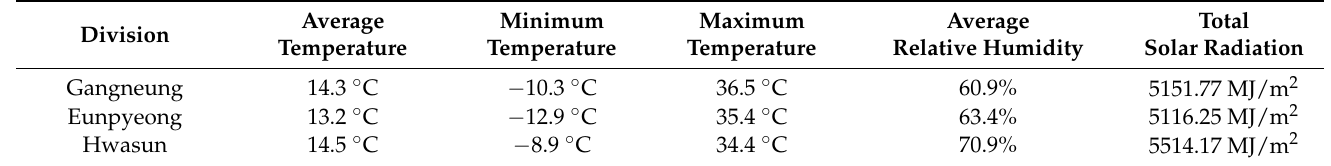
Table 3. Climate information for each